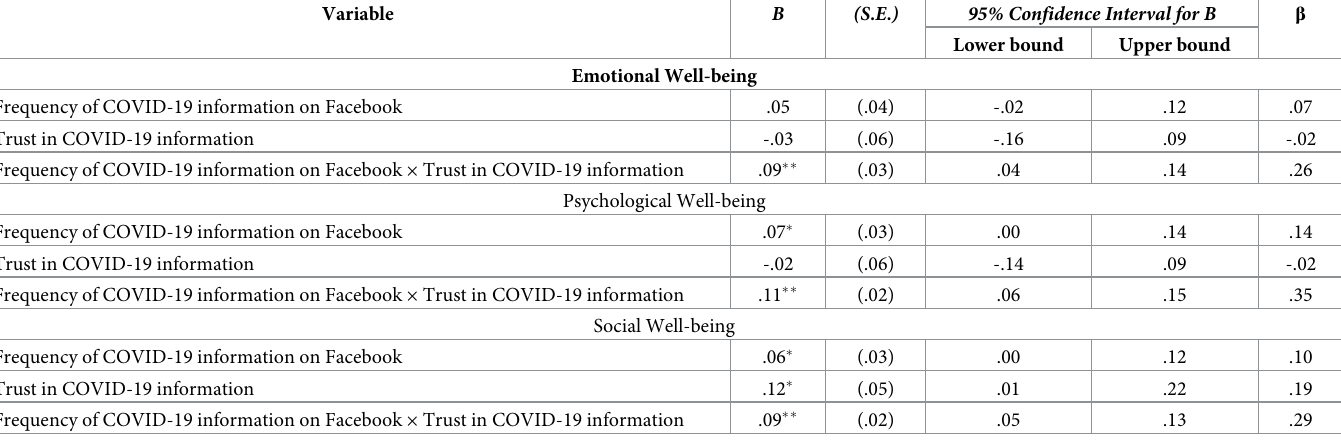
Table 2. Estimates for the main effects and interaction effects of frequency of COVID-19 information on Facebook and trust in COVID-19 information on well-